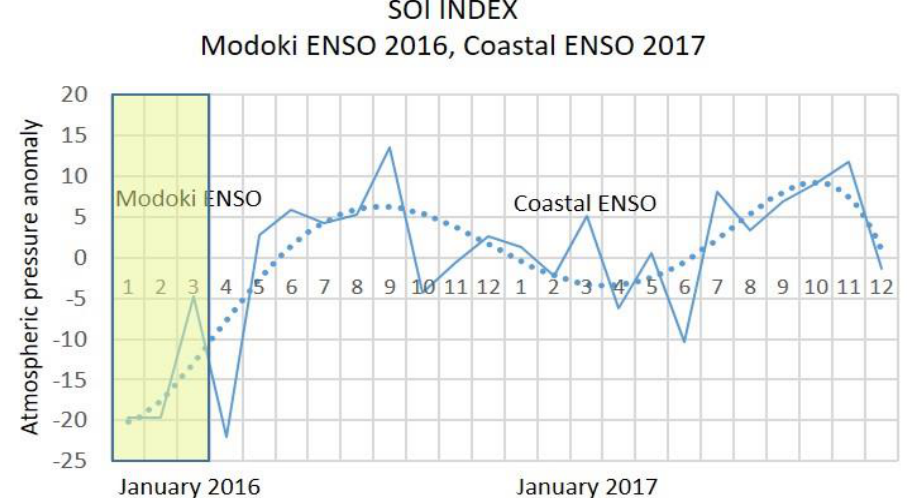
Figure 7. Southern Oscillation Index (SOI) showing the presence of 2016 ’ s Modoki ENSO, but it is also observed that for the year 2017, it does not adequately define the presence of Modoki LNSO.